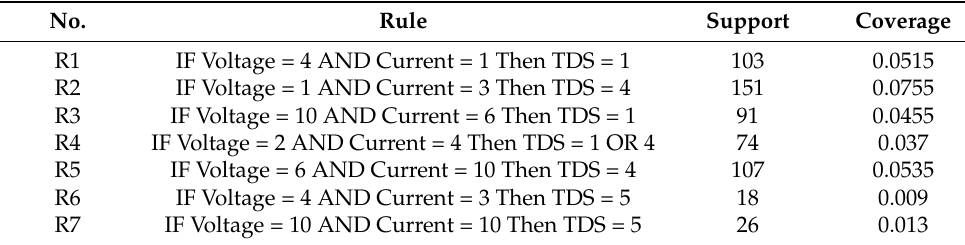
Table 6. Sample of results of Relay#1’s rules.